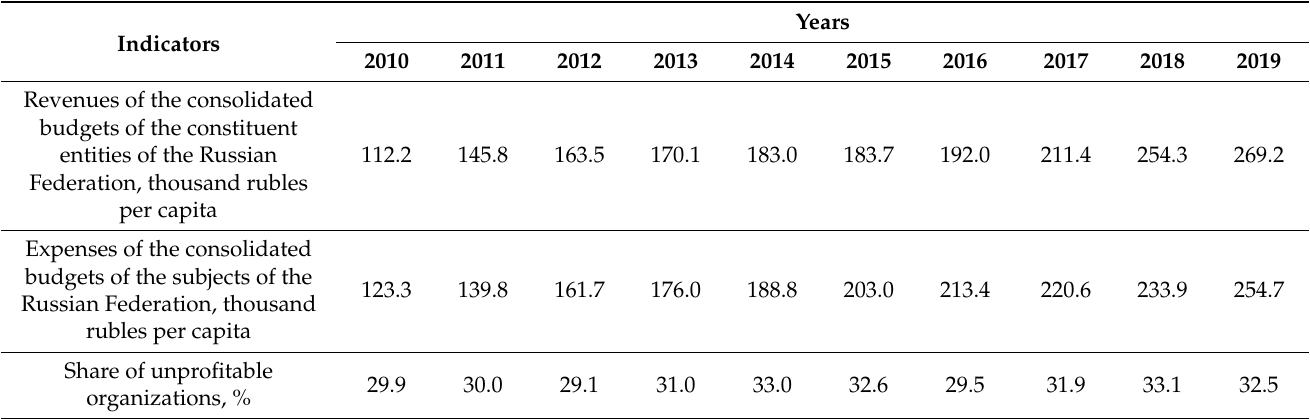
Table 13. Main indicators characterizing the macro-regional block “Finance” in the Russian Federation in